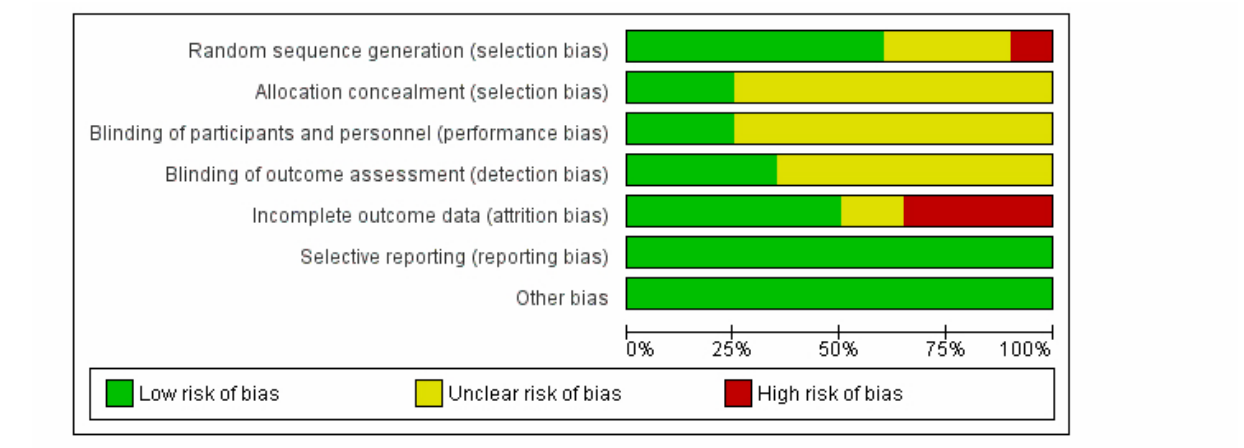
Figure 2. Risk of bias graph for included